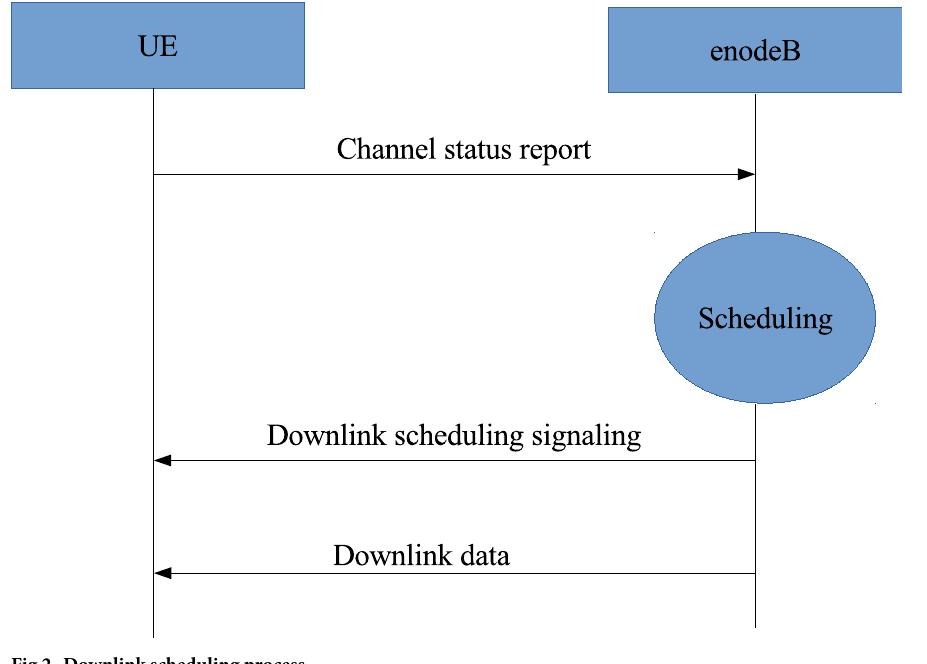
Fig 2. Downlink scheduling